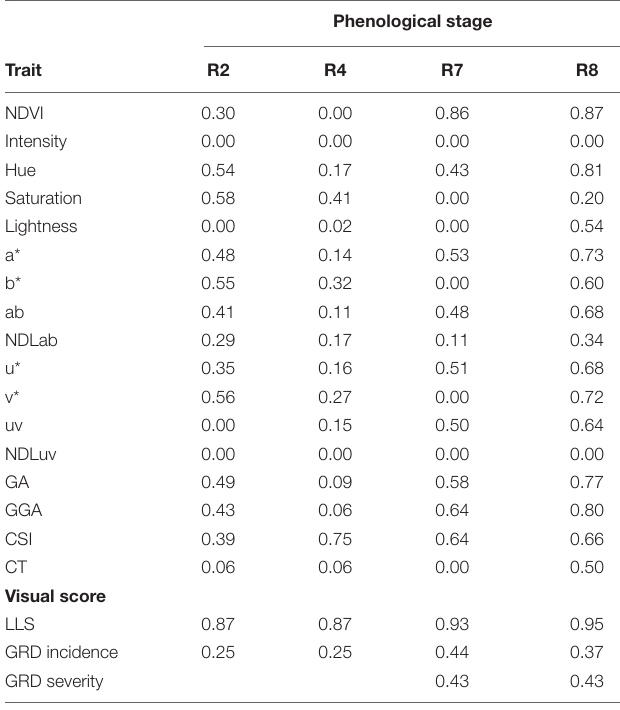
TABLE 6 | Broad-sense heritability of HTP derived indices and visual scores for late leaf spot (LLS) and groundnut rosette virus (GRD) during the 2020A and 2020B growing seasons at different groundnut growth